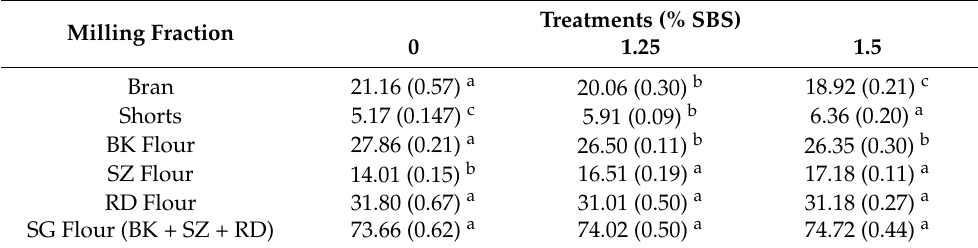
Table 2. Mean (sd) milling yields (%) of tempered